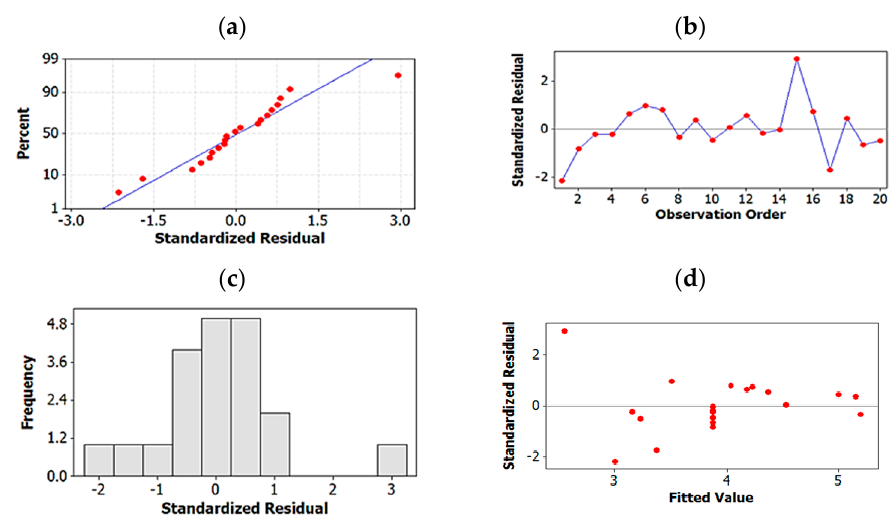
Figure 5. Residual plots for R s 2 : ( a ) normal probability plot of residuals, ( b ) residuals-vs.-fit plots, ( c ) histogram of residuals, ( d ) residuals-vs.-order of data.